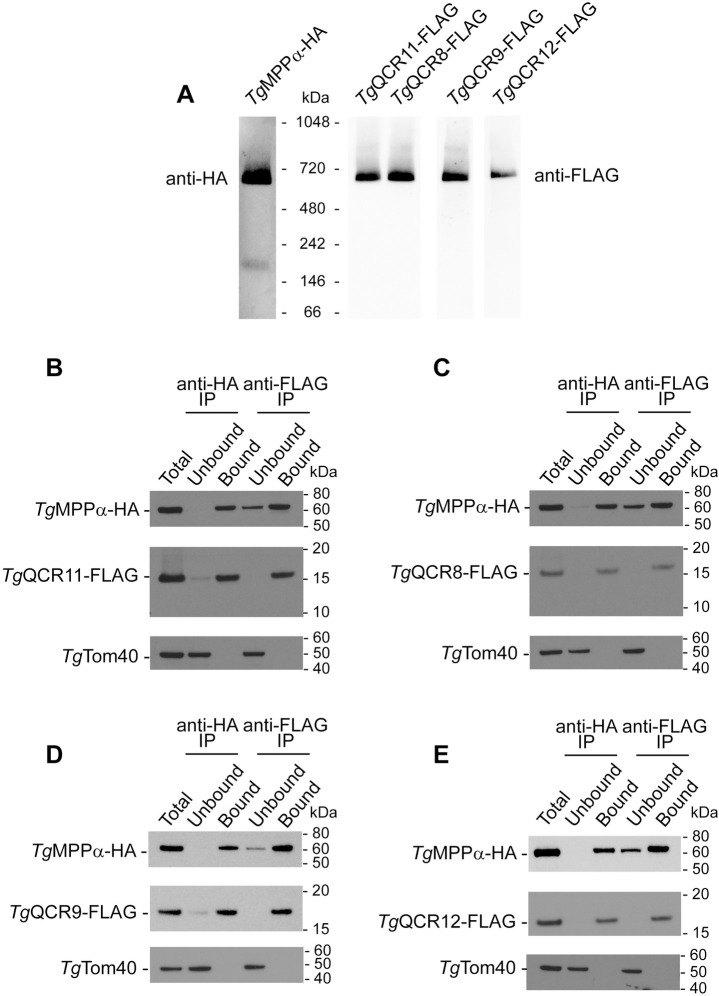
Candidate Complex III subunits are part of a ~675 kDa protein complex and interact with TgMPPα.(A) Western blot of proteins extracted from TgMPPα-TEV-HA (left) or TgMPPα-HA/TgQCR11-FLAG, TgMPPα-HA/TgQCR8-FLAG, TgMPPα-HA/TgQCR9-FLAG and TgMPPα-HA/TgQCR12-FLAG parasites in 1% (w/v) DDM, separated by BN-PAGE, and detected with anti-HA or anti-FLAG antibodies. Images were obtained from a single membrane with lanes cut as indicated and probed with different concentration of antibodies. (B-E) Western blots of proteins extracted from (B)
TgMPPα-HA/TgQCR11-FLAG, (C)
TgMPPα-HA/TgQCR8-FLAG, (D)
TgMPPα-HA/TgQCR9-FLAG or (E)
TgMPPα-HA/TgQCR12-FLAG parasites, and subjected to immunoprecipitation using anti-HA (anti-HA IP) or anti-FLAG (anti-FLAG IP) antibody-coupled beads. Extracts include samples before immunoprecipitation (Total), samples that did not bind to the anti-HA or anti-FLAG beads (Unbound), and samples that bound to the anti-HA or anti-FLAG beads (Bound). Samples were separated by SDS-PAGE, and probed with anti-HA antibodies to detect TgMPPα-HA, anti-FLAG to detect TgQCRs, and anti-TgTom40 as a control to detect an unrelated mitochondrial protein.